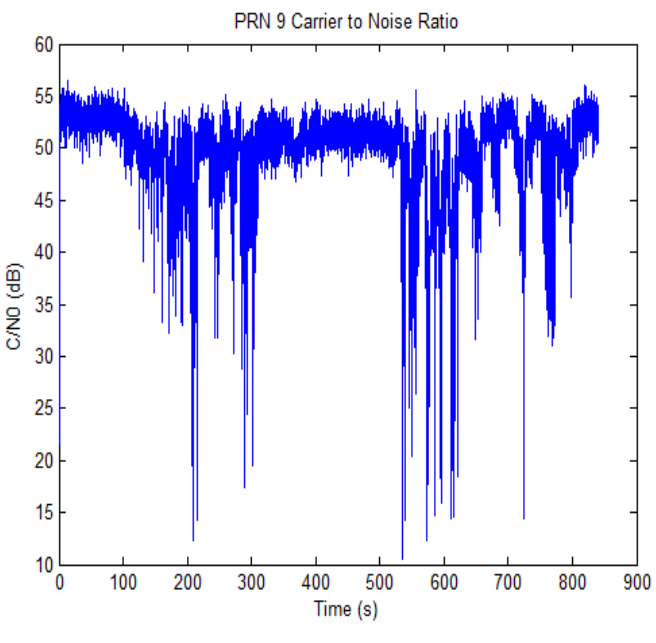
behavior for SV 0